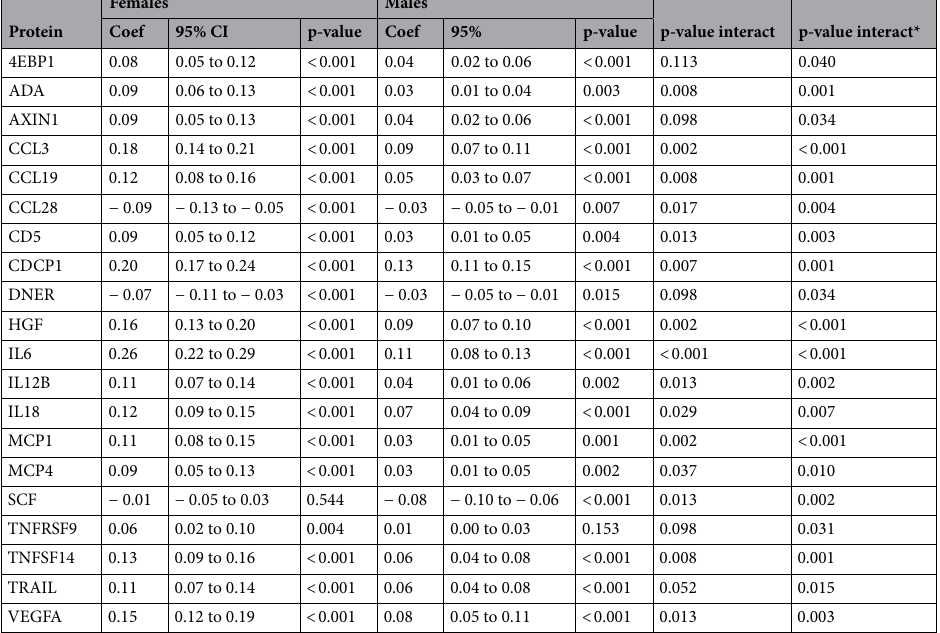
Table 4. Association between visceral fat rating and protein levels in females and males. Stratified analyses in men and women from linear regression of transformed protein levels adjusted for smoking, e-cigarette use, snuff use, and age at follow-up. The table includes all proteins with unadjusted p-value for the interaction term %BF#sex of < 0.05. p-values at 0.05 FDR. *p-value for the interaction term without FDR correction.